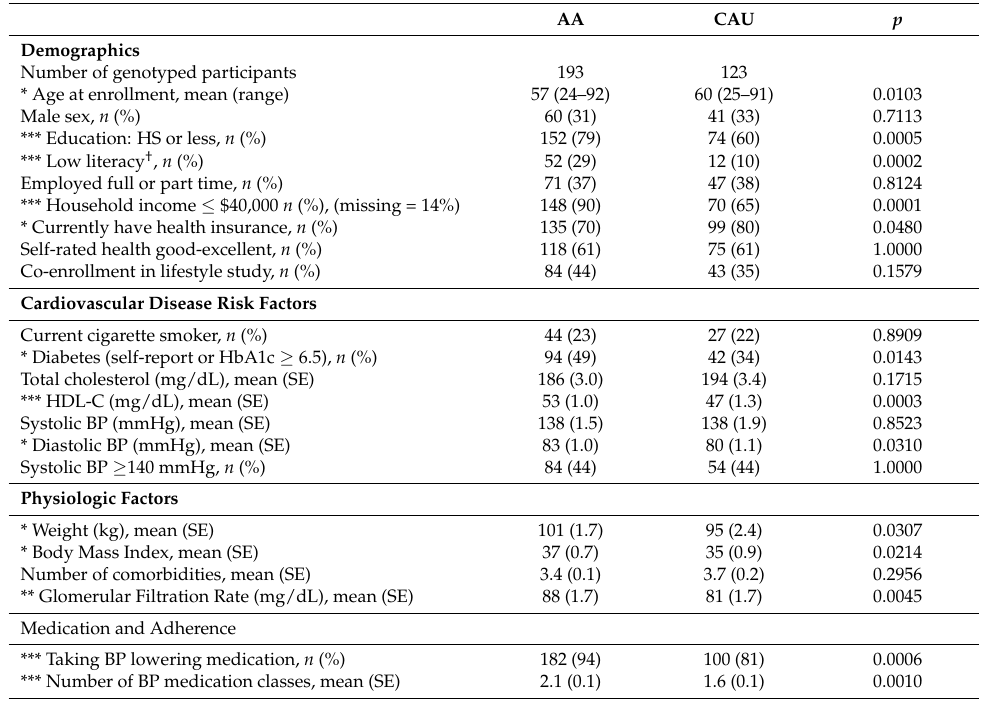
Table 1. Baseline characteristics and ancestral cohort differences of subjects enrolled in the hypertension